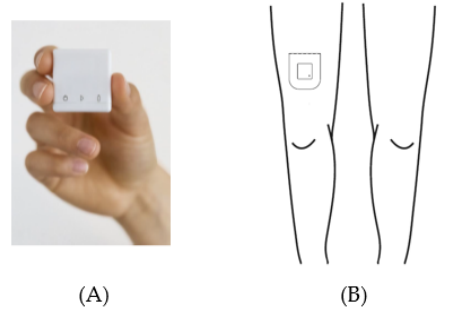
Figure 2. The MOX activity logger ( A ) and the wear location on the upper leg ( B ). The MOX uses a custom-made, double-sided, waterproof, hypoallergenic patch for body attachment. Prior to the physical therapy session, this patch was used to attach the MOX to the upper leg (ten centimeters proximal of the patella, Figure 2B). The upper leg location was chosen as it allows for classification of body postures and movements (e.g., lying/sitting, standing, walking) [76–78]. For the orthopedic patients, the MOX was attached to the non-operated leg. For the acutely hospitalized elderly patients, the MOX was attached to the right leg. Both at the beginning and the end of the physical therapy session, the researcher tapped the MOX twice for the purpose of post-hoc synchronization between the video recording and the raw acceleration data. After the treatment session, the MOX was removed and the raw acceleration data were uploaded to a computer via a USB connection.